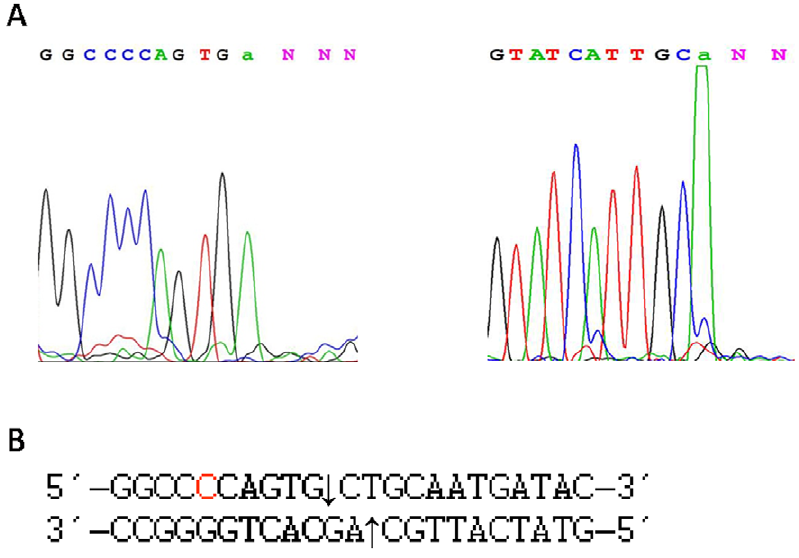
Figure 4. Run-off sequencing to determine the actual cutting site of BtsI-1. A: pUC19 (0.6 m g) was digested by BtsI-1( , 1.8 pmol) and subjected to run-off sequencing with two flanking primers for both directions. The drop in the peak reflects where the polymerase runs off the template at the nicked sites. The terminal ‘‘a’’ is automatically added to the end by the polymerase during sequencing. B: The sequencing data were aligned with pUC19 sequence. The nicking sites are indicated by arrows on both strands.